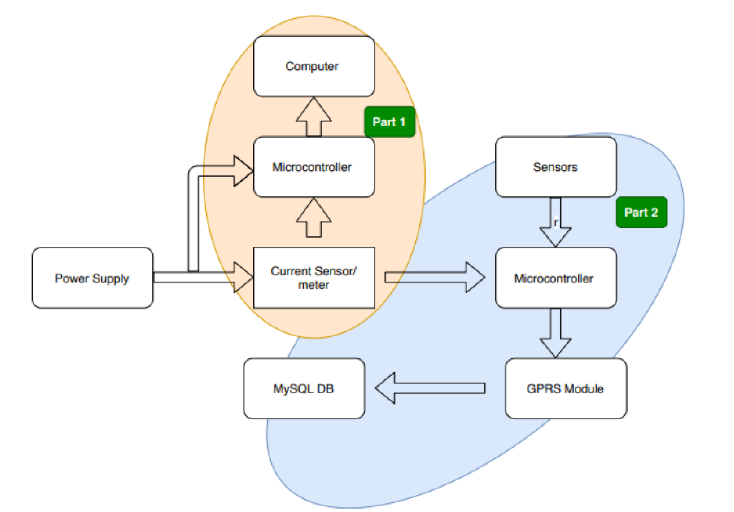
Figure 2. System Block